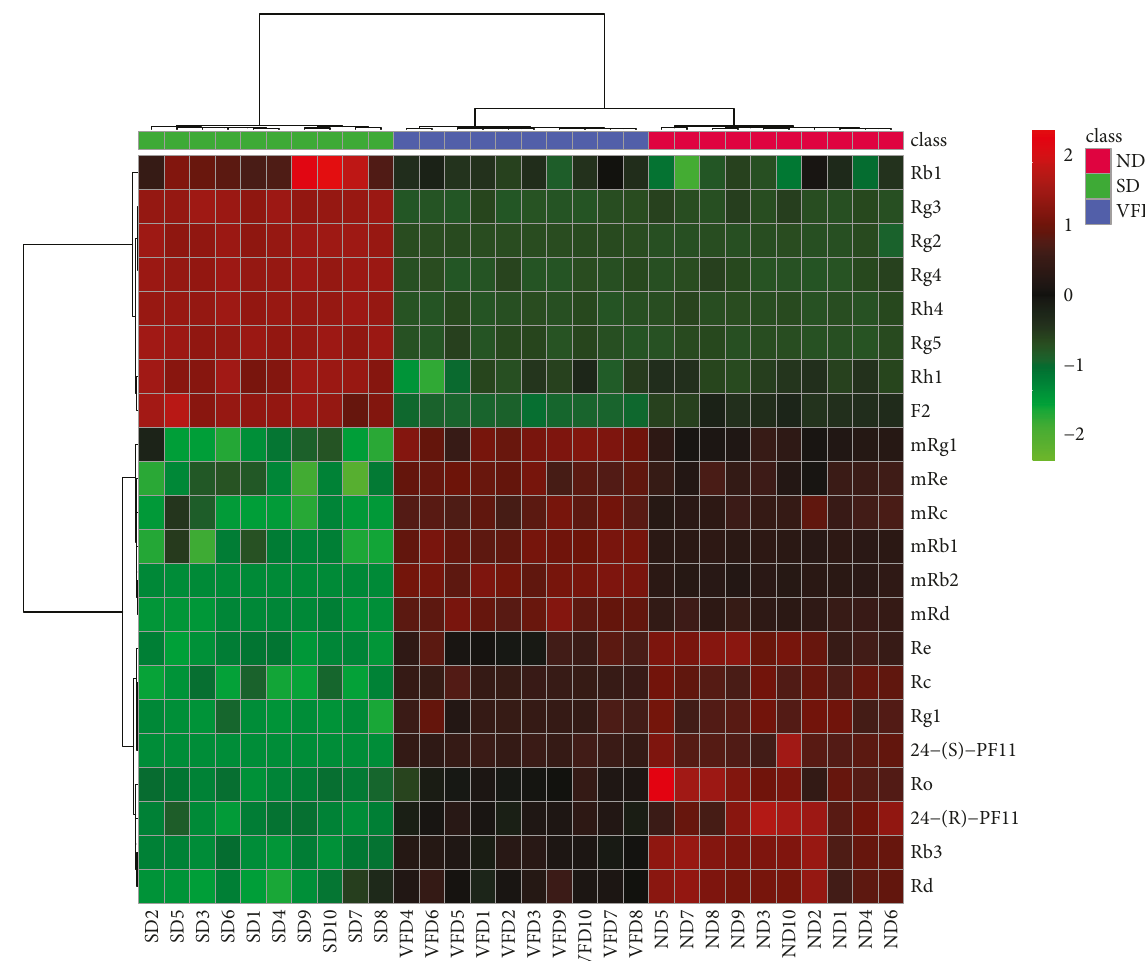
Figure 5: The heat map visualizes the intensities of the 22 ginsenosides datasets from ND, SD, and VFD ( n